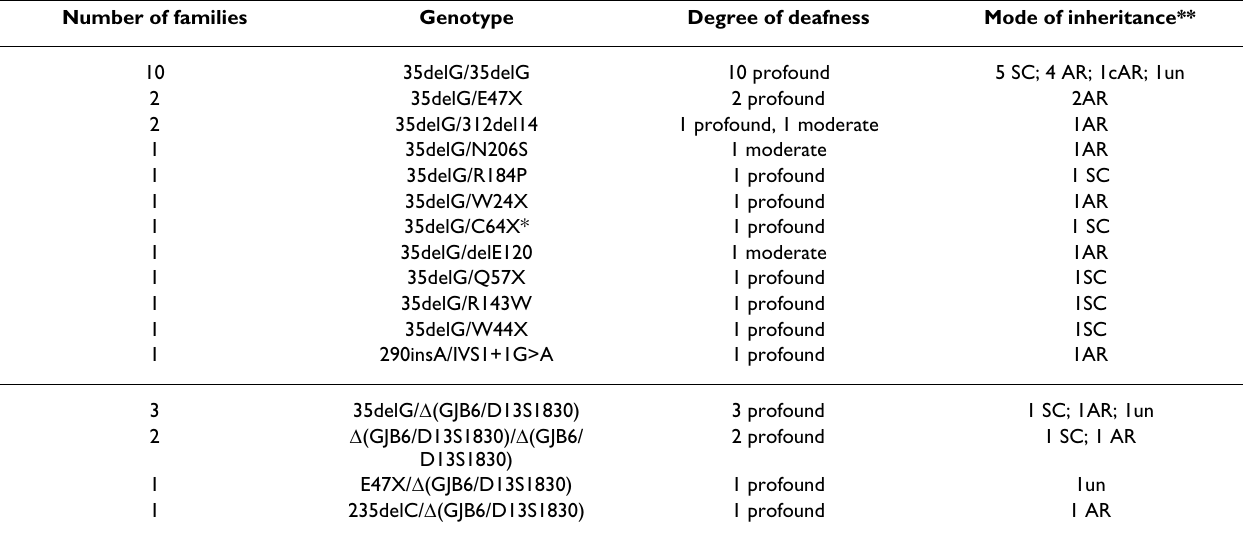
Table 1: DFNB1 genotypes identified in 30 patients with deafness